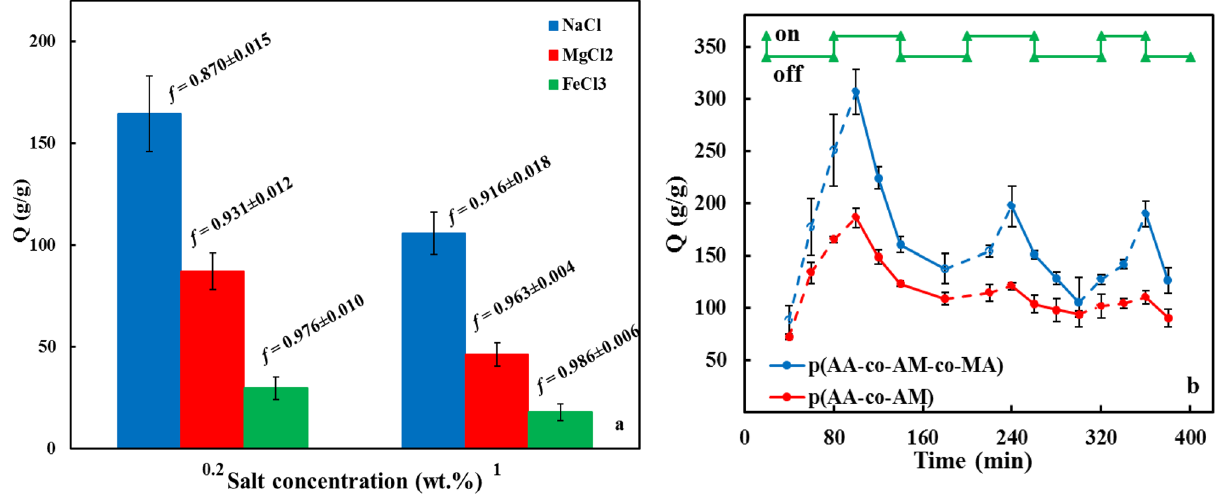
Figure 9. ( a ) salt sensitivity factor ( f ) and water absorbency capacity of p(AA-co-AM-co-MA) superabsorbent, ( b ) The reversible salt-controlled on–off switching for the superabsorbents in DW and SCS. The time interval between the changes was 1